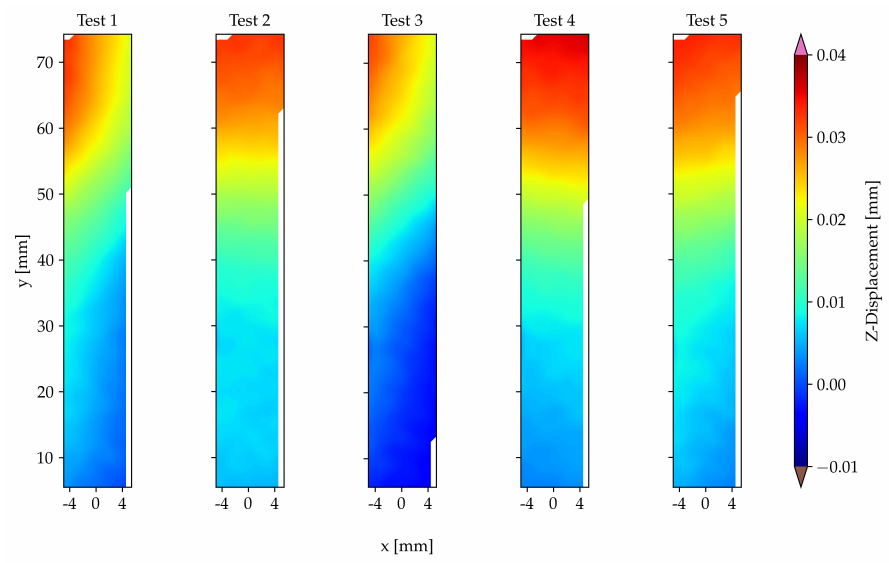
Figure 8. Out-of-plane motion, as captured by stereo-DIC, for the last image taken in the measurement.